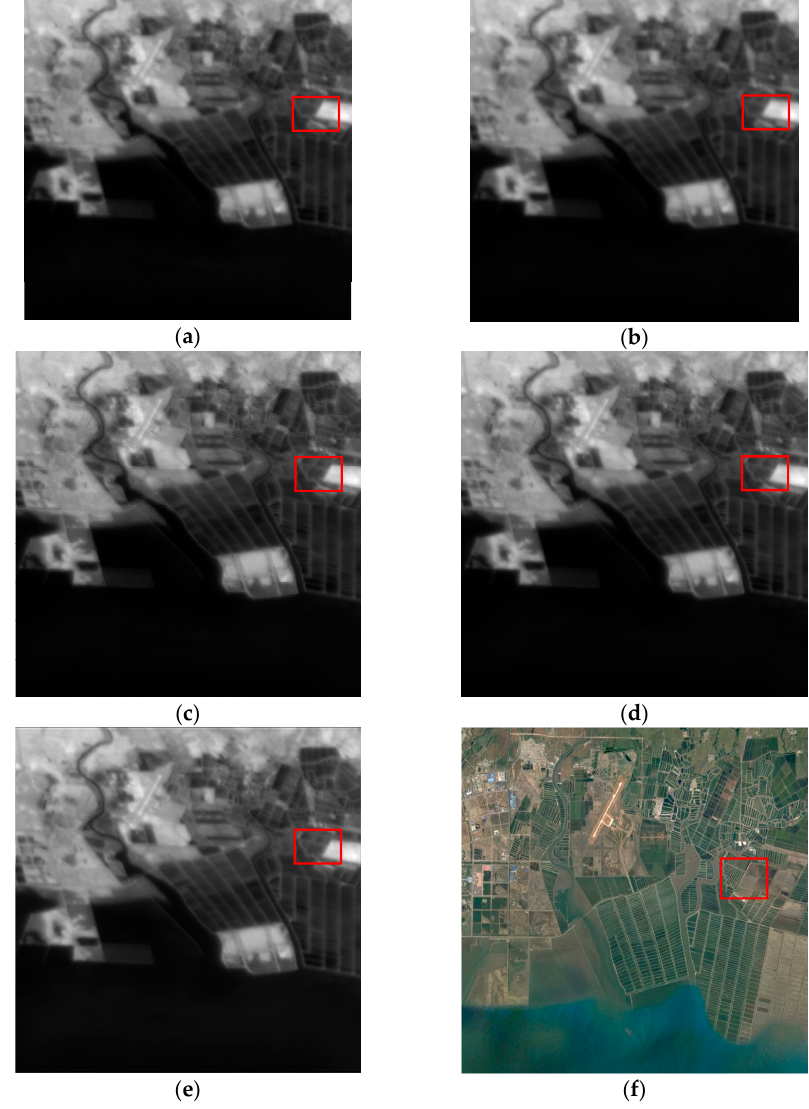
Figure 4. Experimental results of an offshore aquaculture area. ( a ) The bicubic upsampled reference image; ( b ) the added image after registration; ( c ) the HR image reconstructed by the proposed method; ( d ) the HR image reconstructed by IBP; ( e ) the HR image reconstructed by Farsiu’s algorithm; and ( f ) the image chipped from Google